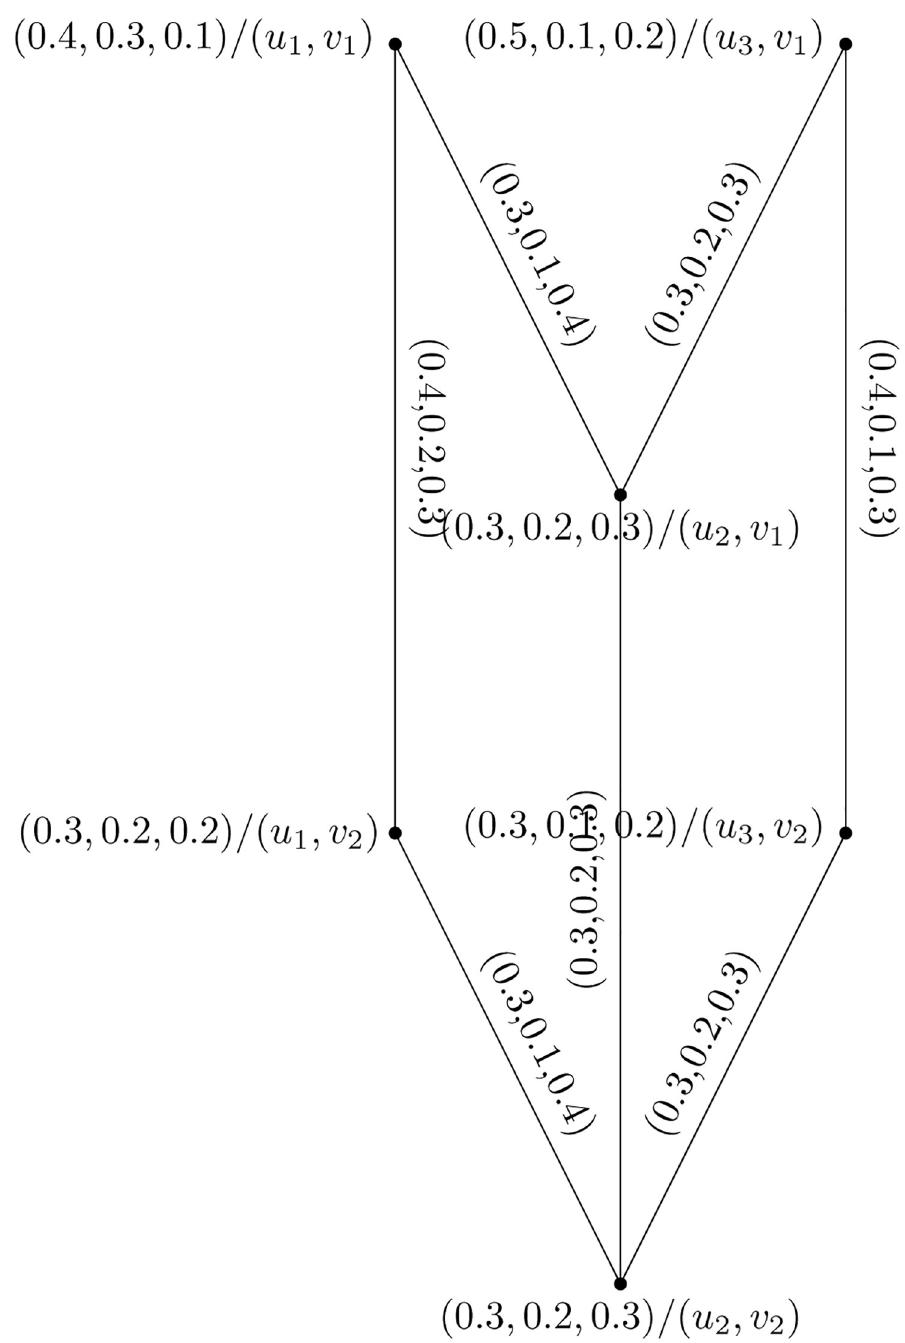
Fig 7. Cartesian product of two picture fuzzy hypersoft